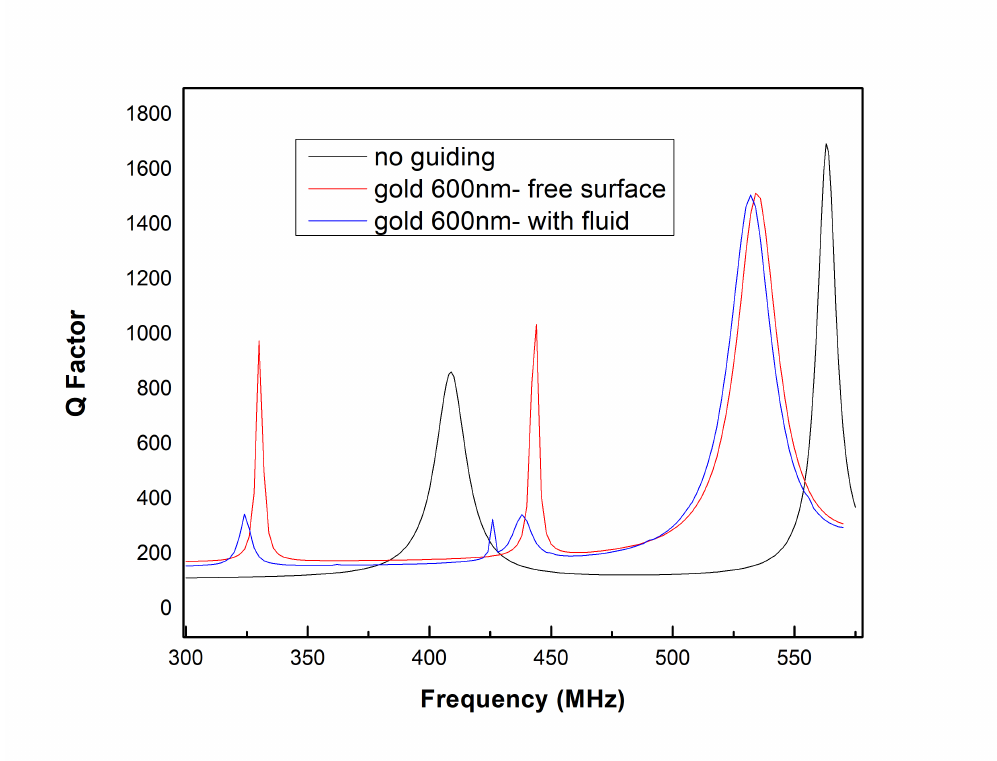
Figure 5. Graph Q factor as a function of frequency for 600 nm of gold guiding layer with the presence of fluid and without